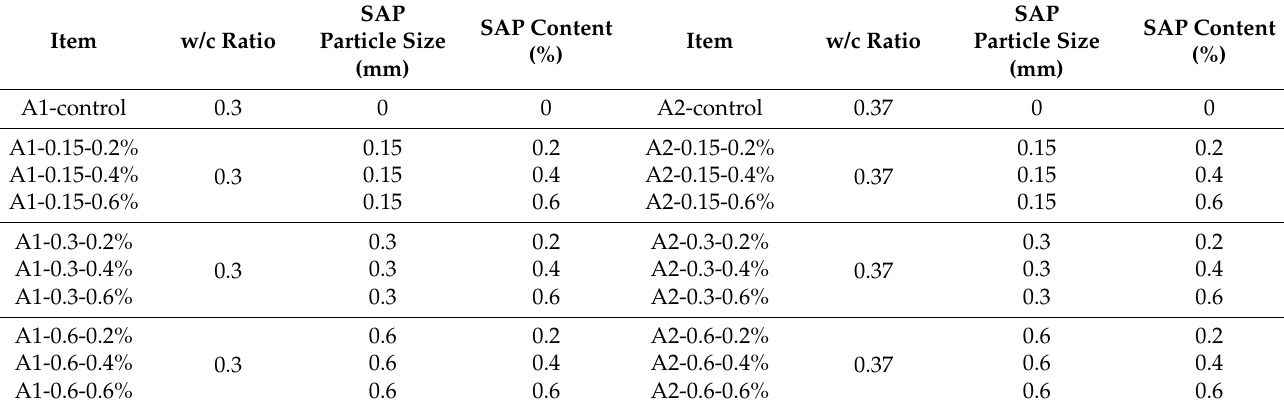
Table 3. Test scheme of Portland cement